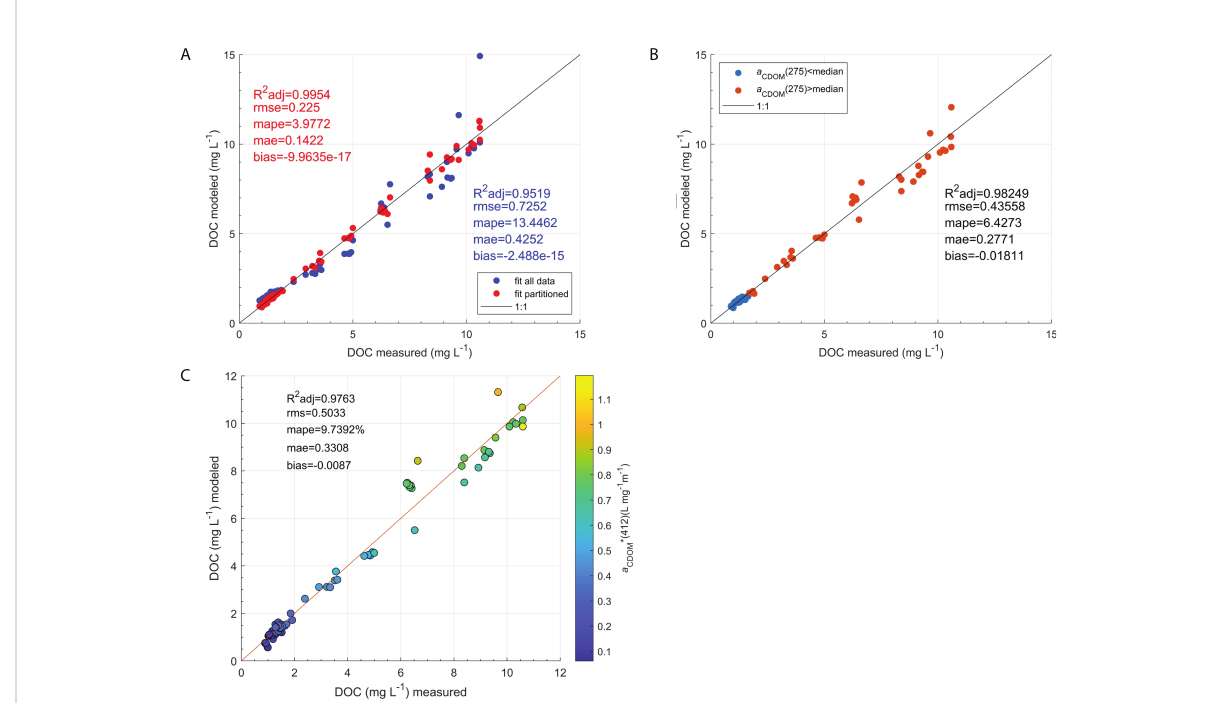
FIGURE 7 (A) DOC derived from the linear relationship of a CDOM (412)(m -1 ) to DOC (mg L -1 ) where: The modeled DOC represented by blue points were calculated from a single fi t to all the data and the red points are modeled from the relationships partitioned seasonally and spatially (Figures 6A, B). (B) DOC modeled from the MLR approach. The data were partitioned based on a CDOM (275)(m -1 ) values above and below the median of a CDOM (275)(m -1 ) =7.05 (m -1 ). A MLR was applied to each subset to derive the coef fi cients to model DOC. (C) DOC modeled from the Exponential fi t to the regression